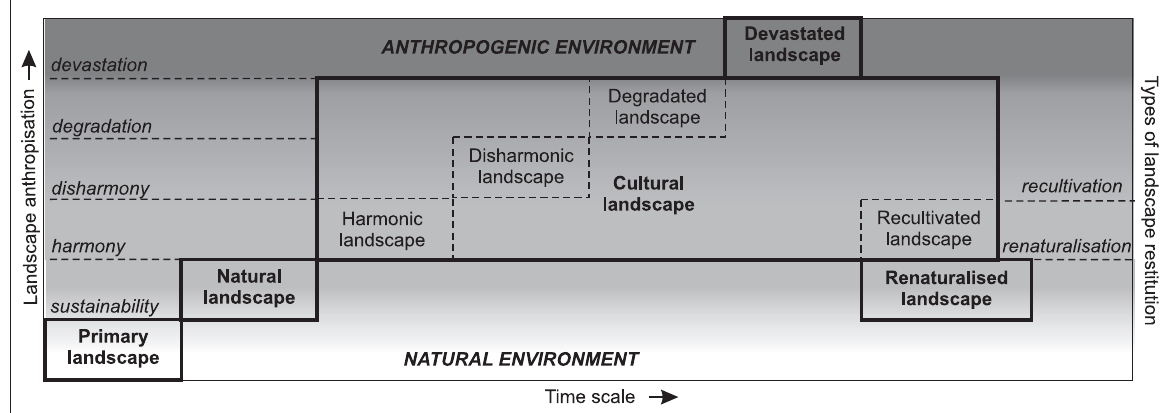
Fig. 1. Model of landscape typology in a context of the anthropisation